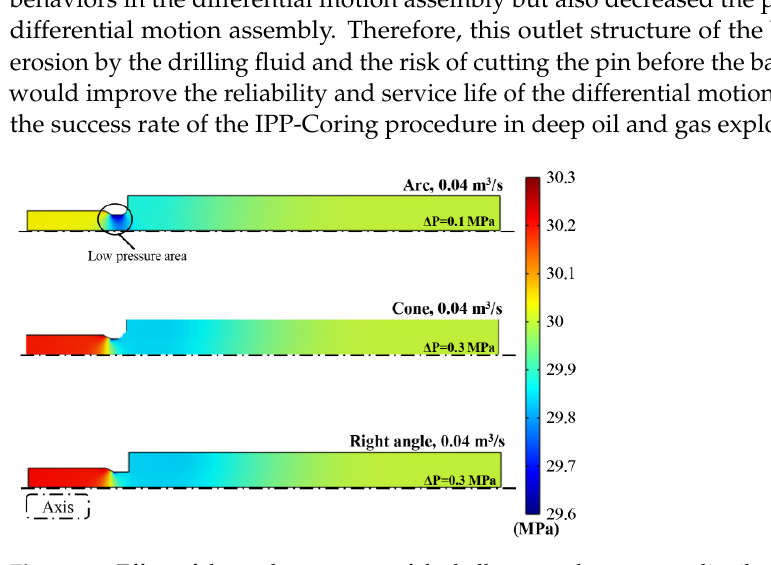
Figure 15. Effect of the outlet structure of the ball seat on the pressure distribution; the fluid viscosity was set as 100 mPa·s.